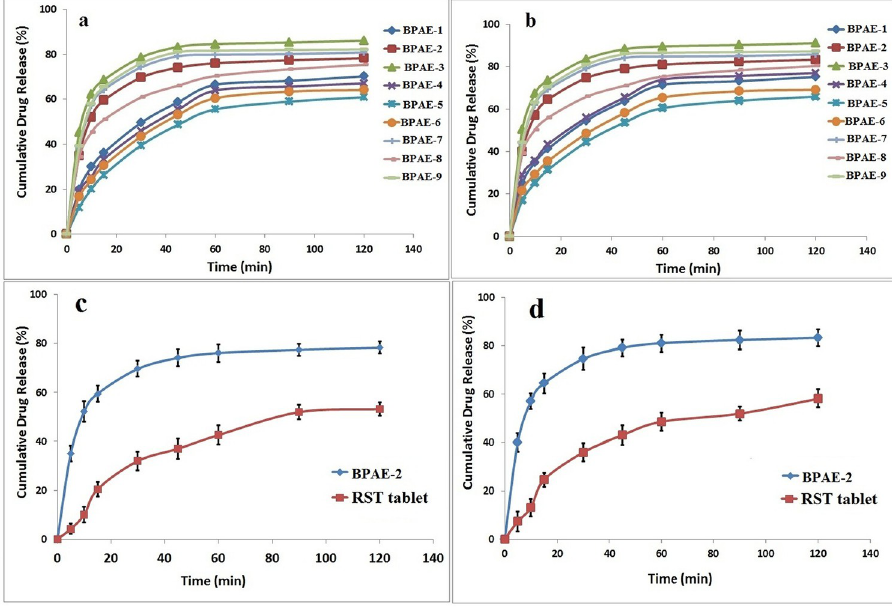
Fig 8. The drug release profile of fabricated nanogels at pH 1.2 (a), pH 6.8 (b) and of commercially available tablets at pH 1.2 (c) and pH 6.8 (d) indicating better release profile of